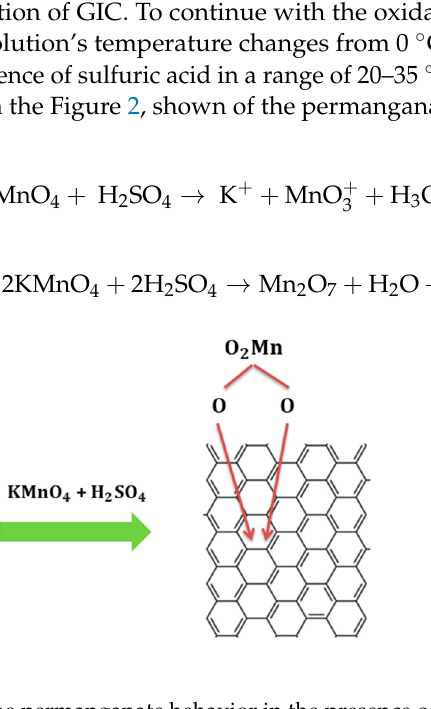
Figure 2. Scheme of the permanganate behavior in the presence of sulfuric acid.